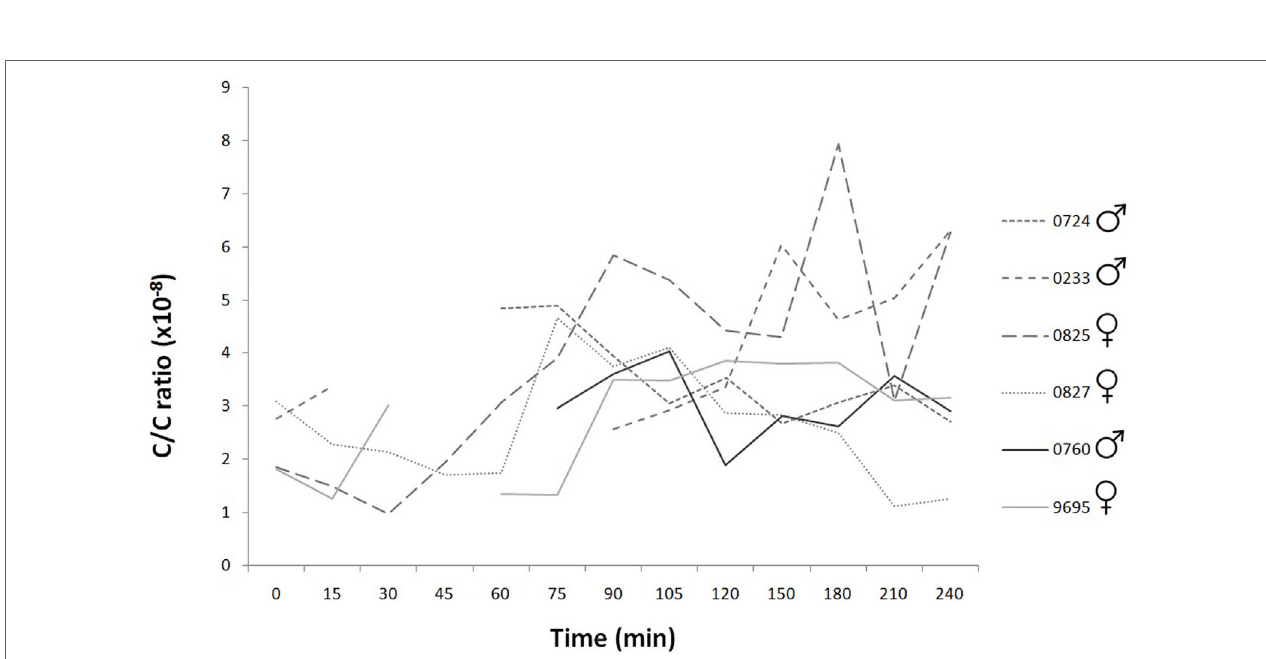
FigUre 3 | Time course of individual urinary cortisol concentrations during the 240 min. Experimental group: dashed line; control group: continuous line.